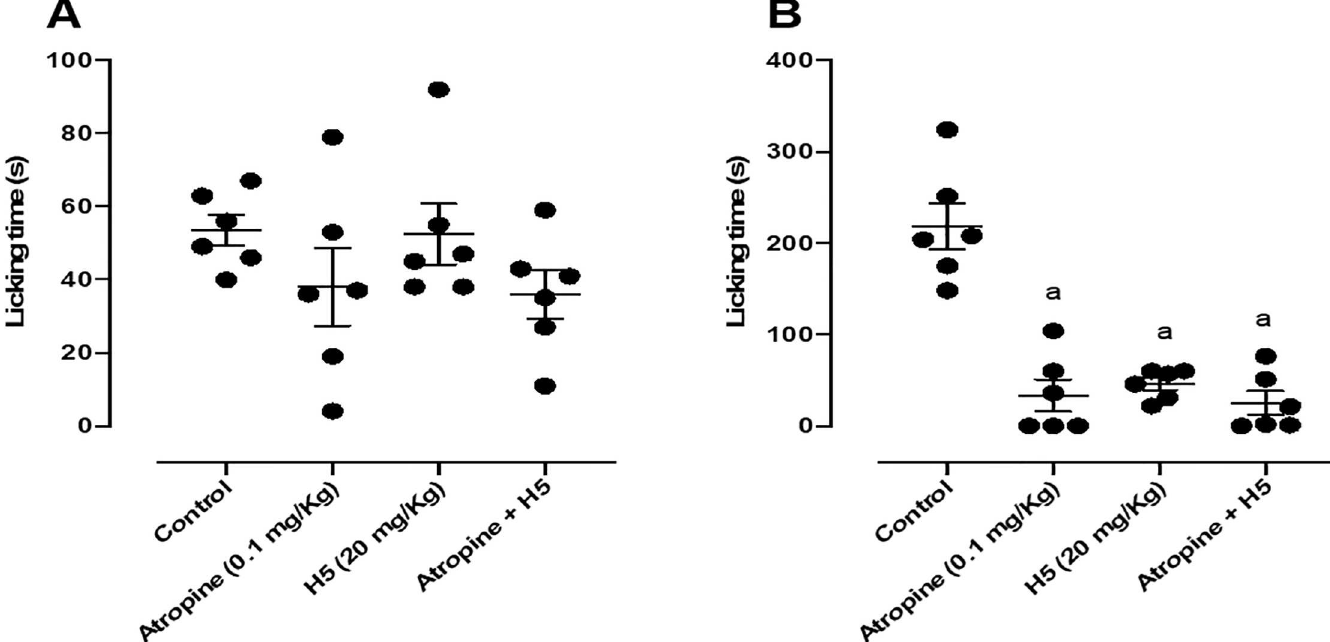
Fig 8. Effect of atropine (0.1 mg/kg, i.p.), H5 (20 mg/kg, p.o.), atropine + H5 in the first (A) and second (B) phases of the formalin-induced nociception test in mice (n = 6, per group). Values are expressed as the mean ± S.E.M., where a indicates p < 0.05 in comparison with control group, according to ANOVA, followed by Tukey’s